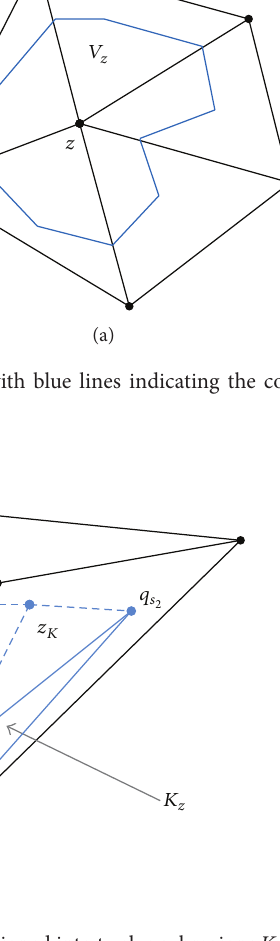
Figure 2: A tetrahedron 𝐾 partitioned into twelve subregions 𝐾 𝑧